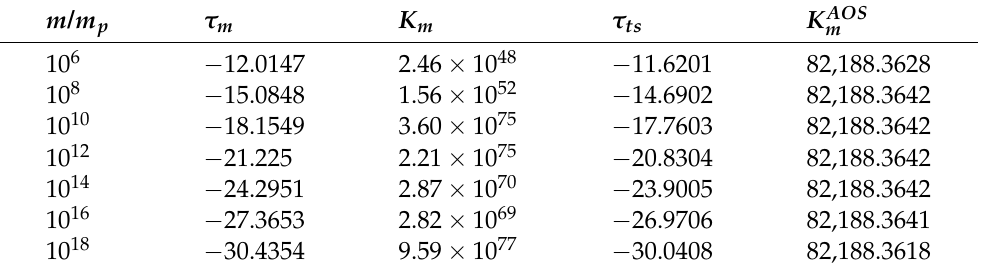
Table 1. The maximal amplitude K m of the Kretschmann scalar K for the case α 1 = 0 with different choices of the mass parameter m . Here τ m denotes the location of the maximal point of K , and τ ts the location of the corresponding transition surface (throat). To compare it with that given by the AOS solution, we also give the maximal values of K AOS m . Here we choose ω bb = − δ b /3 m , ω bc = δ b /3 m , ω cc = − δ c /3 m , and ω cb = 0, so that ( Ω b , Ω c ) = ( 0, − δ c /3 m < 0 ) , where δ i ’s are given by Equation (26).